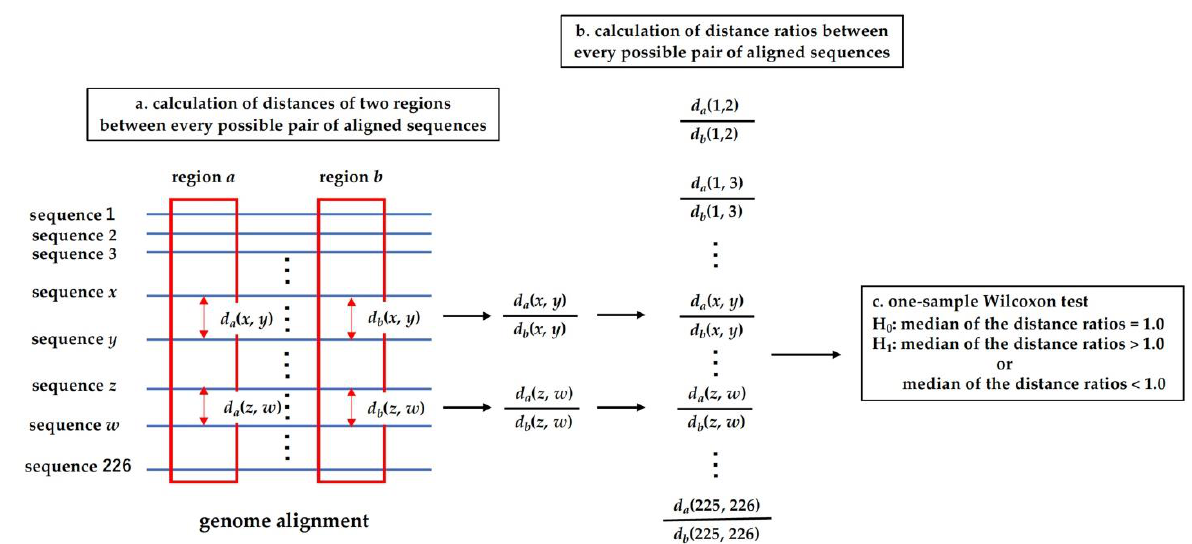
Figure 2. Procedure of the distance ratio analysis. ( a ) Calculation of distances of two regions between every possible pair of aligned sequences. The symbols, d a ( x , y ) and d b (x , y ), indicate the evolutionary distance between sequences x and y in region a and that in region b . The distances d a ( x , y ) and d b ( x , y ) correspond to one of the five distances ed bp ( x , y ), ed nbp ( x , y ), ed ( x , y ), K c s ( x , y ) , and K c a ( x , y ) . For simplicity of the explanation, the two regions are drawn as separate regions in an alignment. However, the regions can be overlapped. For example, when distance ratios of K c a ( x , y ) and K c s ( x , y ) are examined as d a ( x , y ) and d b (x , y ), the regions a and b are the non-synonymous and synonymous sites of the same coding region. ( b ) Calculation of distance ratios between every possible pair of aligned sequences. If d b (x , y ) equals zero, the corresponding distance ratio is not included in the set of the distance ratios. ( c ) One-sample Wilcoxon test. There are two alternative hypotheses, the median of the ratios > 1.0 and the median of the ratios < 1.0, which correspond to the right-sided and left-sided test. One of the two alternative hypotheses was adopted based on the median of the calculated distance ratios. That is, when the median was larger than 1.0 (less than 1.0), the right-sided (left-sided) one-sample Wilcoxon test was applied to the data of distance ratios.